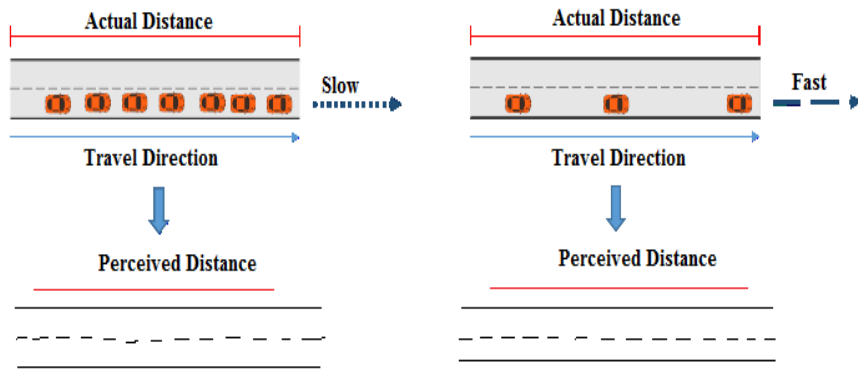
Figure 2. The actual length of a road segment as contrasted to the perceived length.